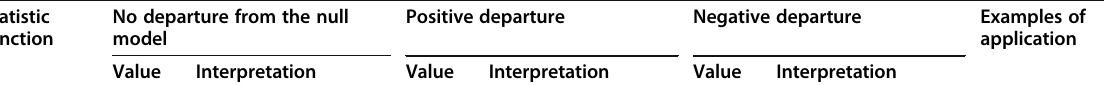
Table 1 Second-order summary statistics commonly used in spatial point-pattern analysis. In the univariate analysis, only one pattern is involved (e.g. one species, one size or age class, one life stage, etc.), while in the bivariate version two patterns (1 and 2) are investigated (e.g. two different species, two size classes, two life stages, etc.). For the mark correlation analysis, the most studied mark is by far tree diameter. In the case of random labelling analysis, the marks usually consist of tree status (e.g. dead vs living). For all analysis types, positive, negative, or absence of departure from the null model simulation envelopes occurs at a given scale